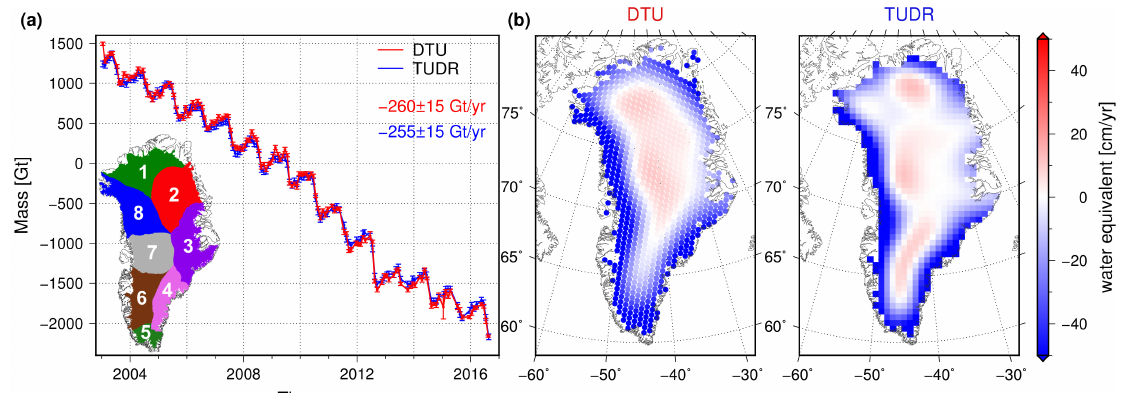
Figure 4. GMB products provided by the ESA Greenland ice sheet CCI project. ( a ) Mass change time series for the entire Greenland ice sheet generated by DTU (red) and TUDR (blue). ( b ) Ice mass trends for 2007–2011 provided by DTU ( left ) and TUDR ( right ). All products are based on monthly solutions from the CSR RL06 series. Numbers indicate mass balance estimates and the corresponding